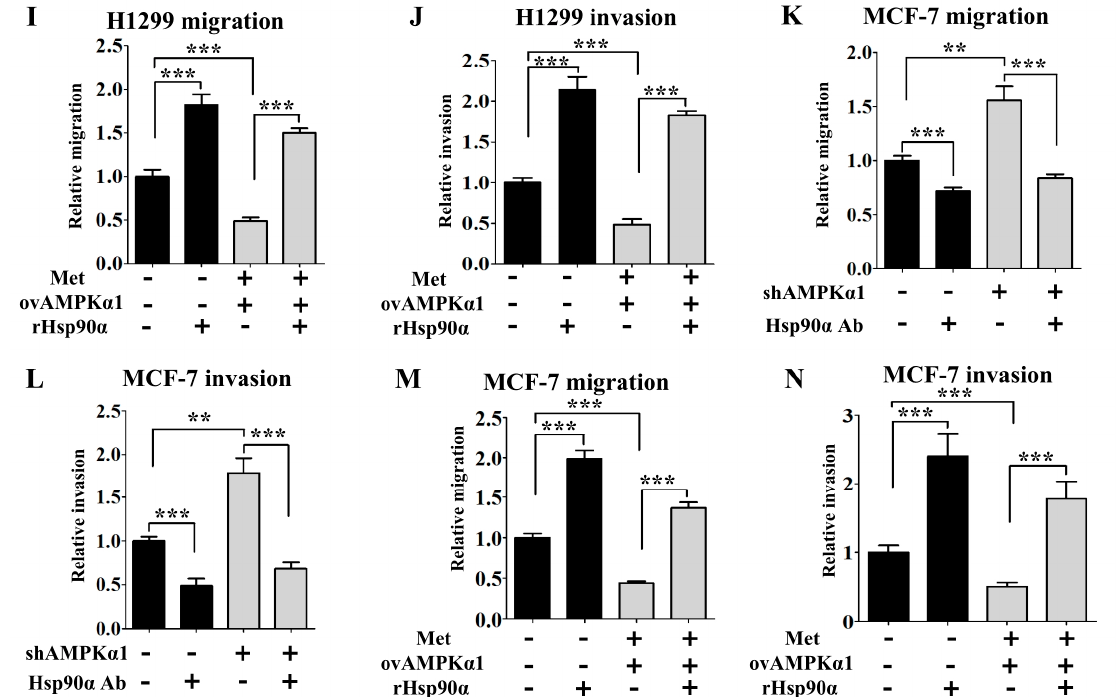
Figure 4. Metformin inhibits Hsp90 α secretion in an AMPK α 1 dependent manner. Extracellular Hsp90 α was measured in the conditioned medium of AMPK α 1 KD ( A ) and AMPK α 1 OV ( B ) H1299 cells treated with or without metformin (200 µ M). Western blots of AMPK α , p-AMPK and actin were also shown. Co.St (Coomassie brilliant blue) was used as a control. shAMPK α 1 meant the stable knockdown of AMPK α 1. ov AMPK α 1 meant the stable overexpression of AMPK α 1. Representative images of H1299 KD cells migration ( C ) and invasion ( D ) treated with or without Hsp90 α antibody. Quantified results of H1299 cells migration ( E ) and invasion ( F ). Representative images of H1299 OV cells migration ( G ) and invasion ( H ) treated with or without recombinant Hsp90 α . Quantified results of H1299 cells migration ( I ) and invasion ( J ). Scale bar, 100 µ m. ** p < 0.01, *** p < 0.001. Quantified results of MCF-7 KD cells migration ( K ) and invasion ( L ) treated with or without Hsp90 α antibody. Quantified results of MCF-7 OV cells migration ( M ) and invasion ( N ) treated with or without recombinant Hsp90 α